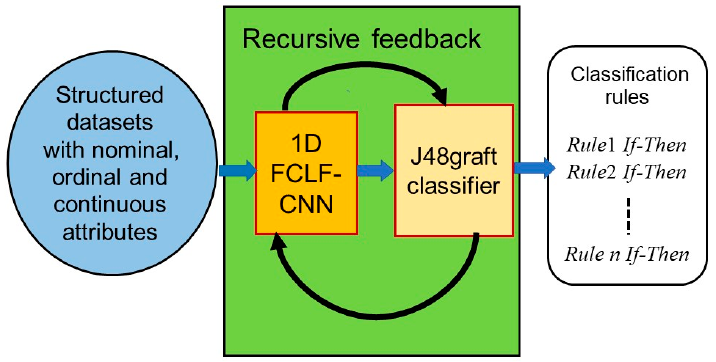
Figure 6. Schematic overview of the proposed one-dimensional fully-connected layer first convolutional neural network (1D FCLF-CNN) with Re-RX with J48graft.